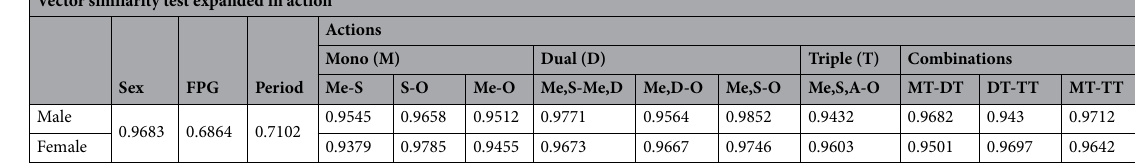
Vector similarity test expanded in